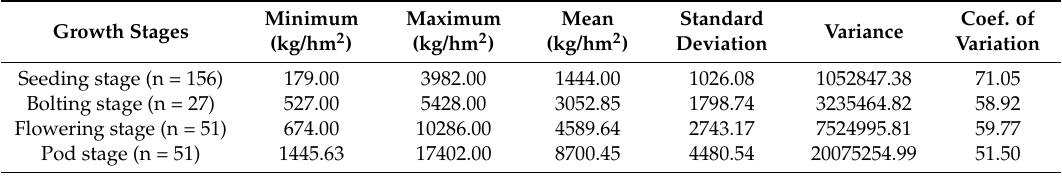
Table 4. The statistical characteristics of aboveground biomass (AGB) from 2014 to